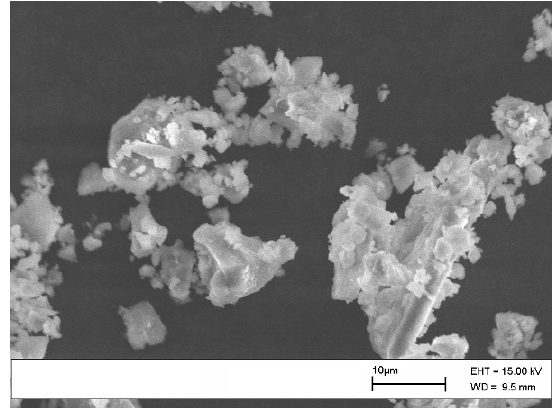
Figure 8. SEM micrograph of Mg/Ni/Al the magnesium nitrate